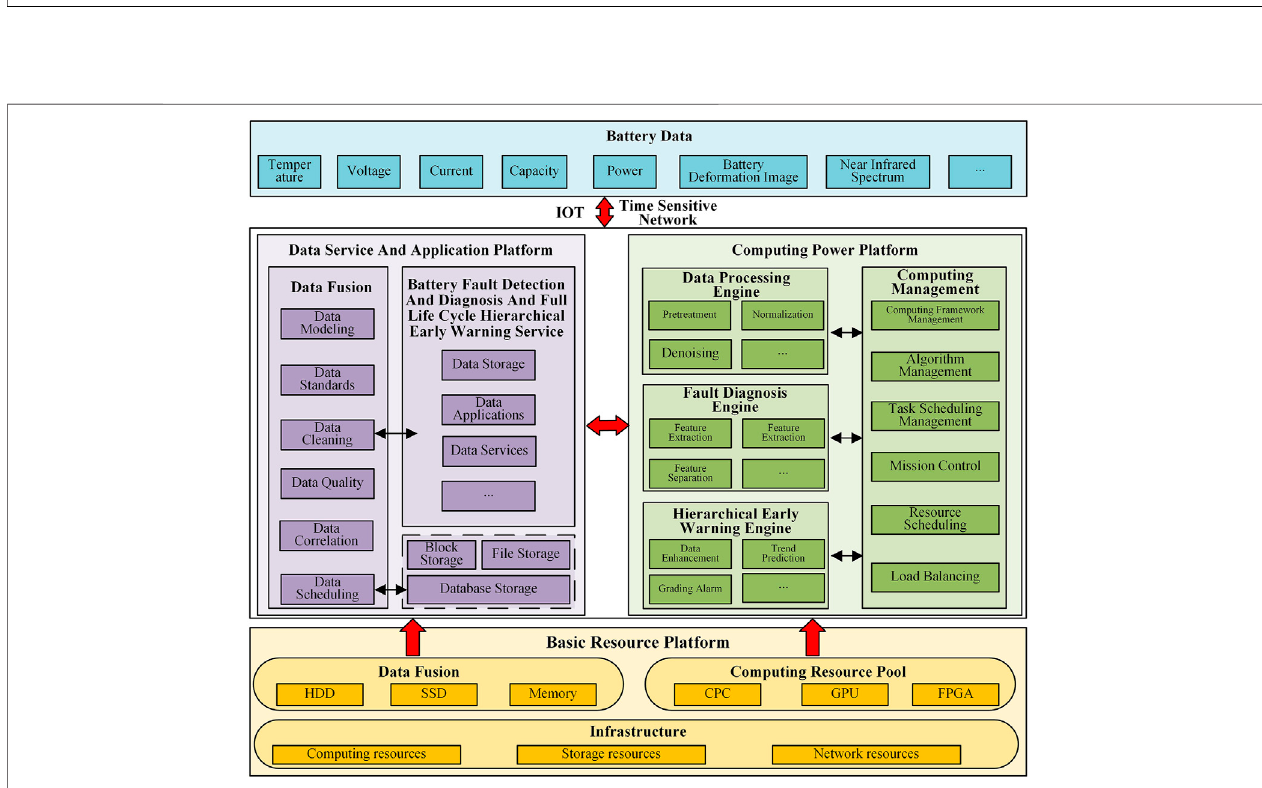
FIGURE 13 | Big data monitoring system based on multi-tier microservice architecture.